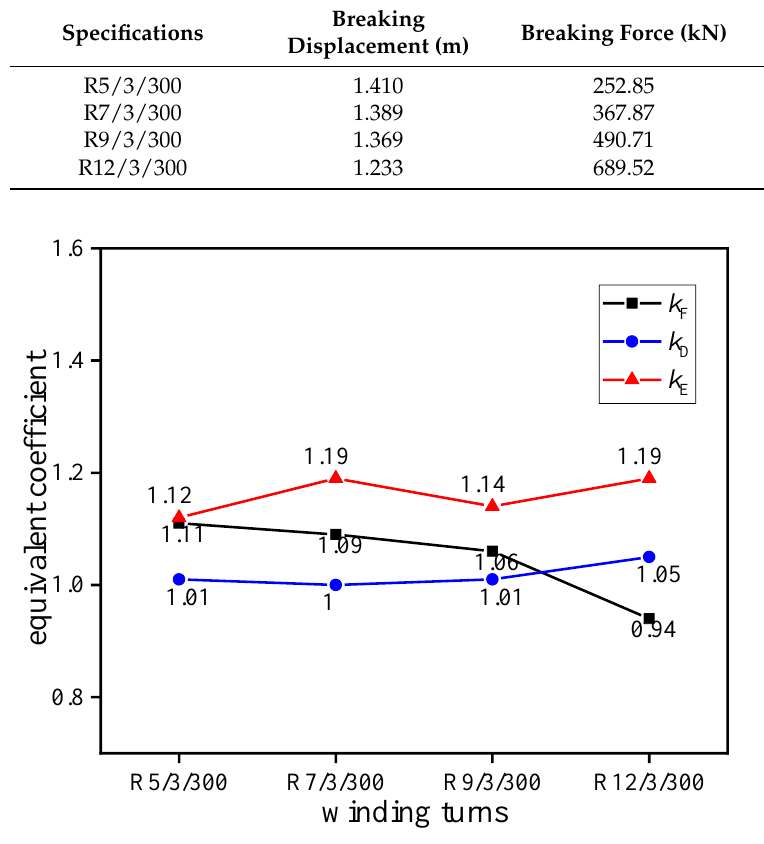
Figure 9. Correlation coefficient curves under different winding turns.